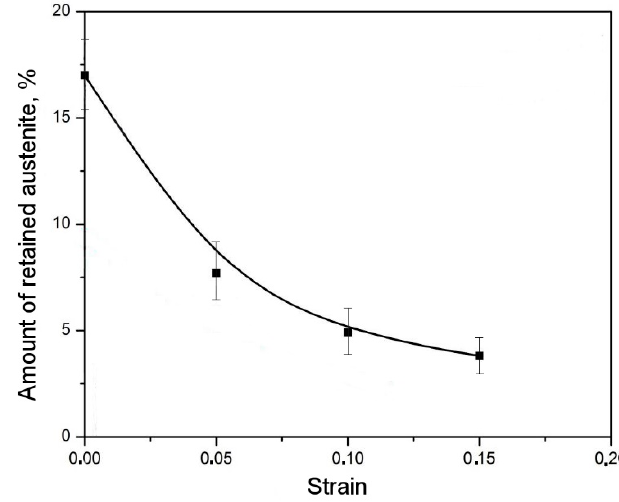
Figure 6. Microstructures showing the evolution of strain ‐ induced martensitic transformation of retained austenite (RA) obtained in interrupted tensile tests. Specimens deformed to elongation values: 5% ( a ), 10% ( b ), and up to rupture ( c ); M—martensite, α B —bainitic ferrite.